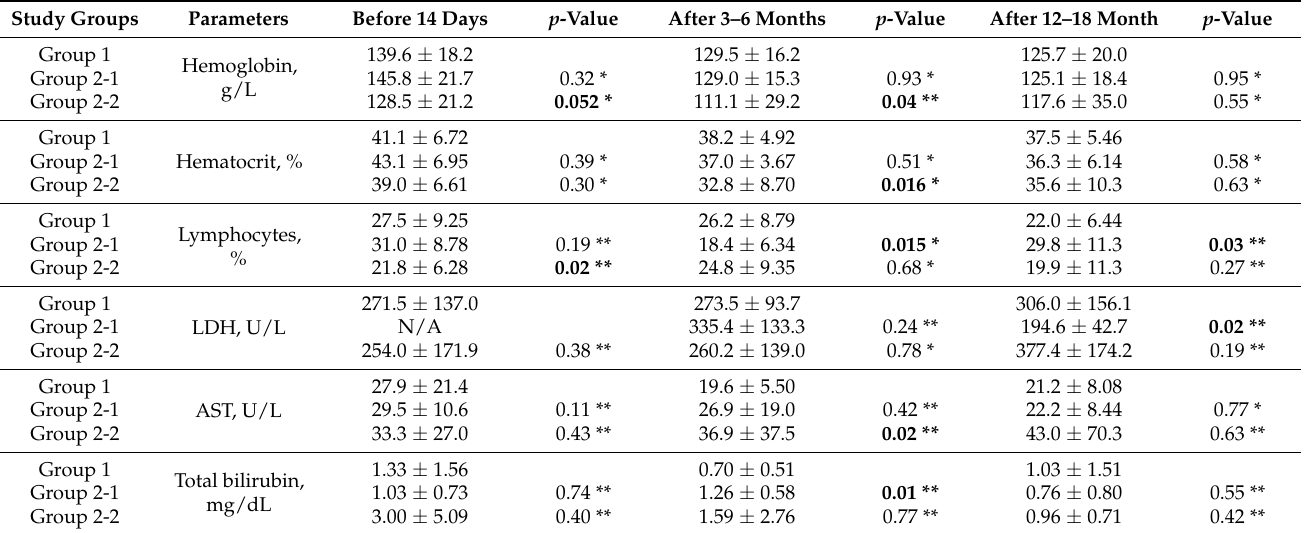
Table 3. Comparative analysis of biochemical parameters between HF patients without complications, with thrombosis and bleeding